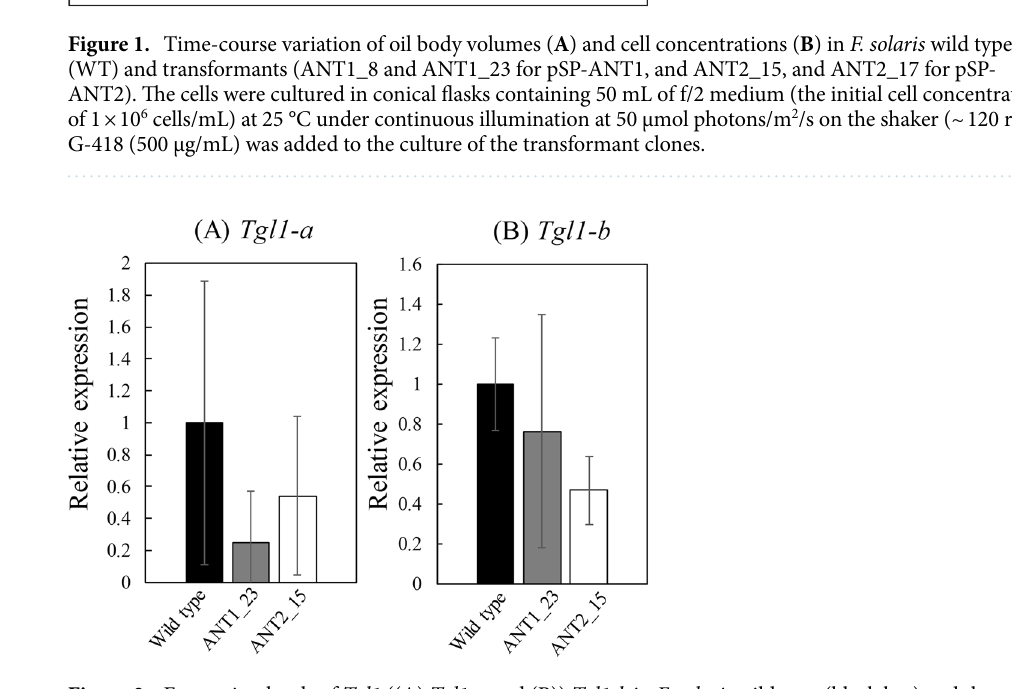
Figure 2. Expression levels of Tgl1 ((A) Tgl1-a and (B)) Tgl1-b in F. solaris wild type (black bar) and the transformants ANT1_23 (gray bar) and ANT2_15 (white bar) after 72 h cultured in f/2 medium. Transcription abundance was normalized with that of GAPDH gene. Values are means ± SD of three independent